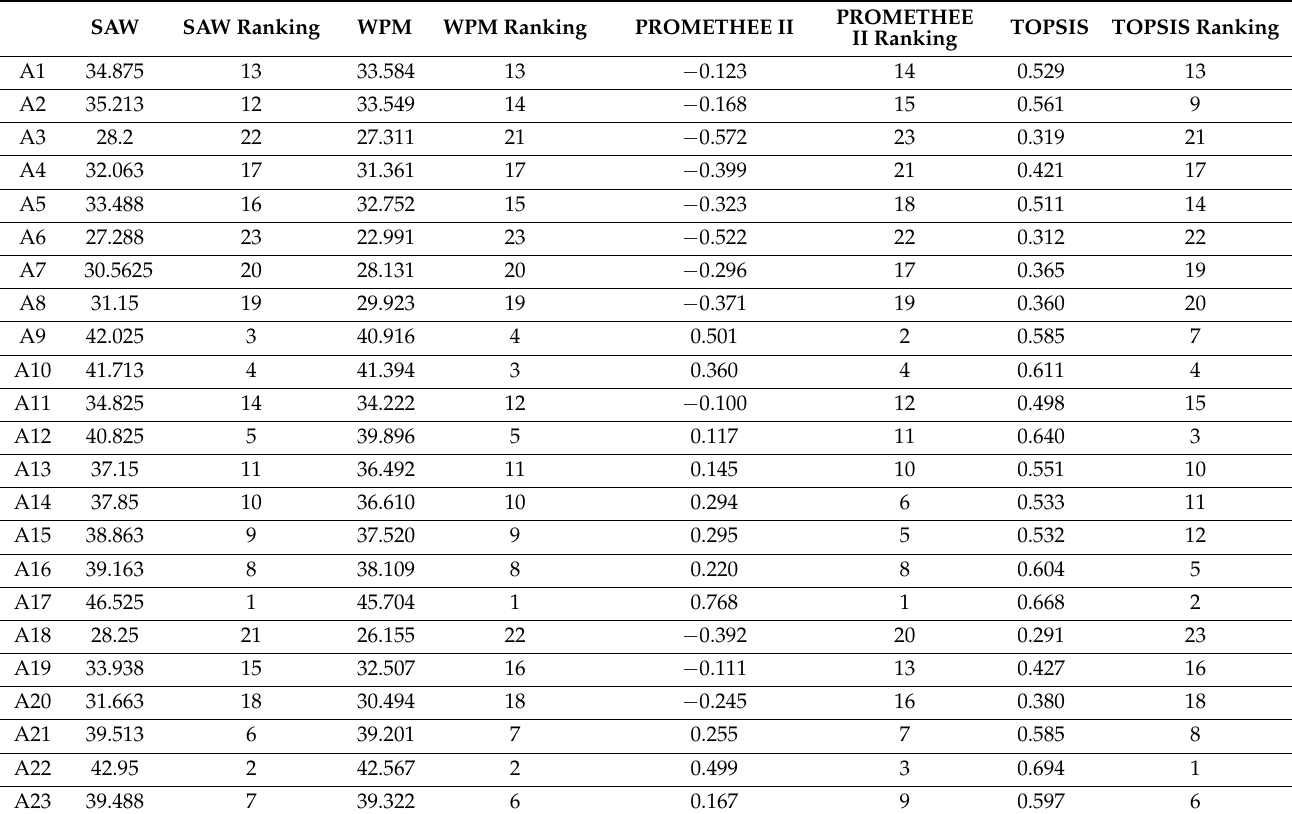
Table 5. Values and Ranking order for all websites using SAW, WPM, and PROMETHEE II using equal weights of criteria.